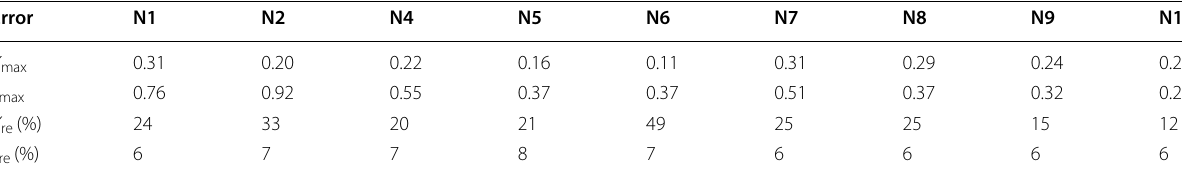
Table 3 Kriging prediction errors at different positions